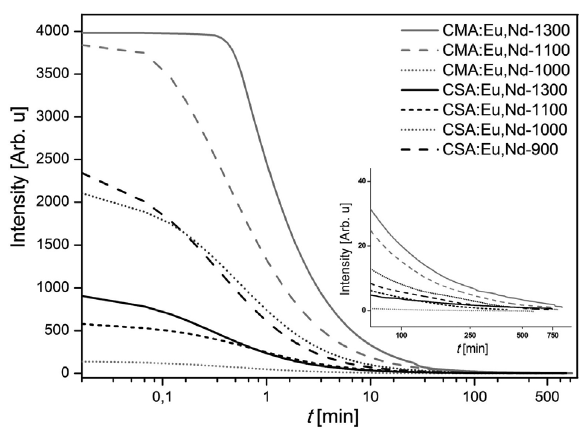
Figure 8. Persistent luminescence lifetimes of samples with the no- minal formulae CMA:0.5Eu 2+ ,0.25Nd 3+ and CSA:0.5Eu 2+ ,0.25Nd 3+ measured at room temperature. The inset graph is a magnification of the tails of the curves. The legend of the curves is ordered by ap-